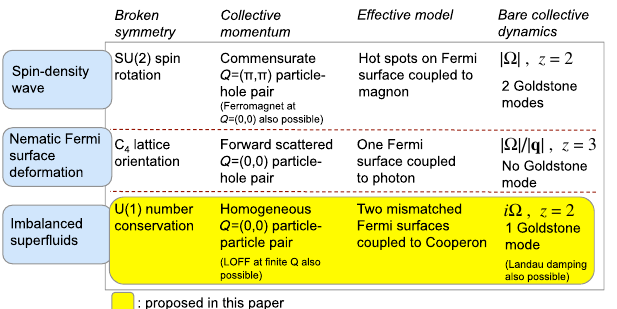
FIG. 2. Plain vanilla non-Fermi-liquid “ metal ” quantum phase transitions at finite fermion density in two spatial dimensions.